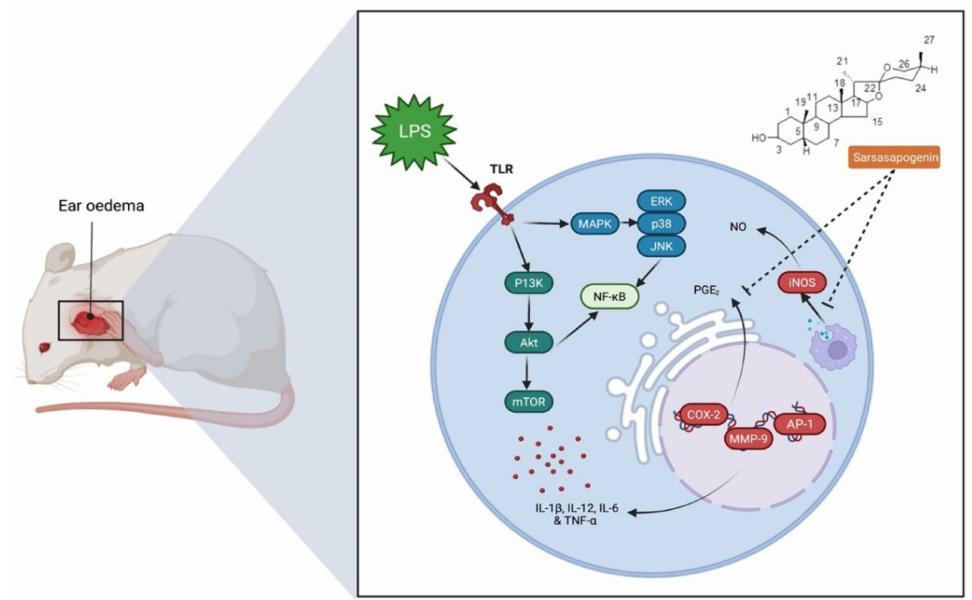
Figure 4. Mechanism of inhibition exhibited by sarsasapogenin in ear oedema. Sarsasapogenin reduced iNOS expression and PGE2 levels, which suppressed the inflammation generated by LPS and ameliorated ear oedema. MAPK, mitogen-activated protein kinase; ERK, extracellular-signal- regulated kinase; JNK, c-Jun N-terminal kinase; NF-kB, nuclear factor kappa-light-chain-enhancer of activated B cell; P13K, phosphatidylinositol-3-kinase; Akt, Ak strain transforming; mTOR, mam- malian target of rapamycin; TLR, Toll-like